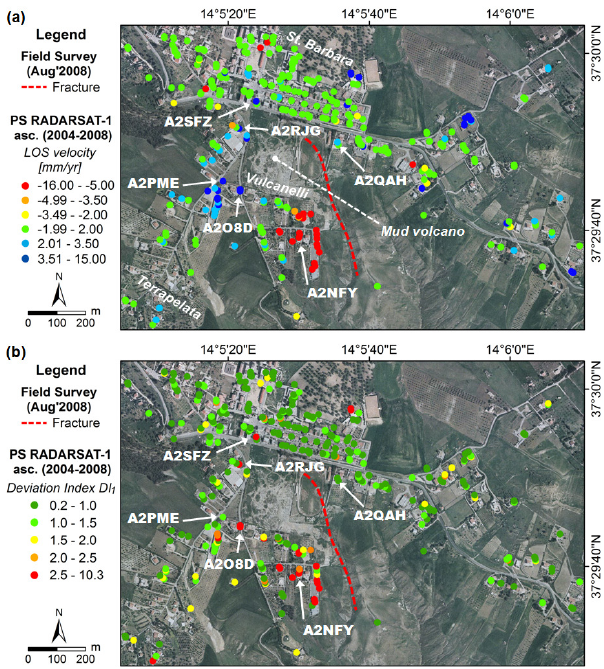
Fig. 5. St. Barbara test site: LOS velocity (a) and Deviation Index DI 1 (b) Figure 5. St. Barbara test site: LOS velocity (a) and Deviation Index DI 1 (b).629